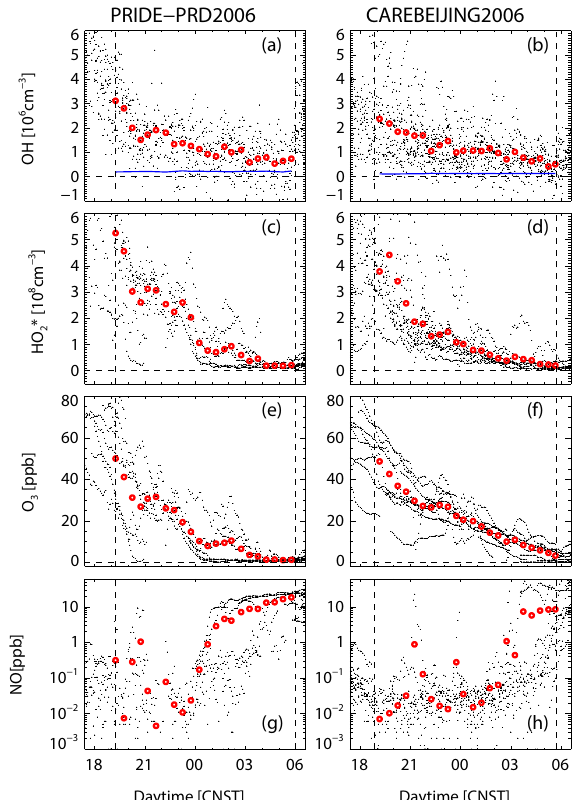
Figure 1. Observed concentrations of OH, HO ∗ , O 3 , and NO dur- 2 ing PRIDE-PRD2006 and CAREBEIJING2006. The black symbols denote the original measurements; the red circles denote half-hourly averaged values. NO is displayed on a logarithmic scale. In (a) and (b) , the corresponding 1 σ OH detection limits (1h) are shown as solid blue lines. The local sunset and sunrise times are marked by the dashed vertical